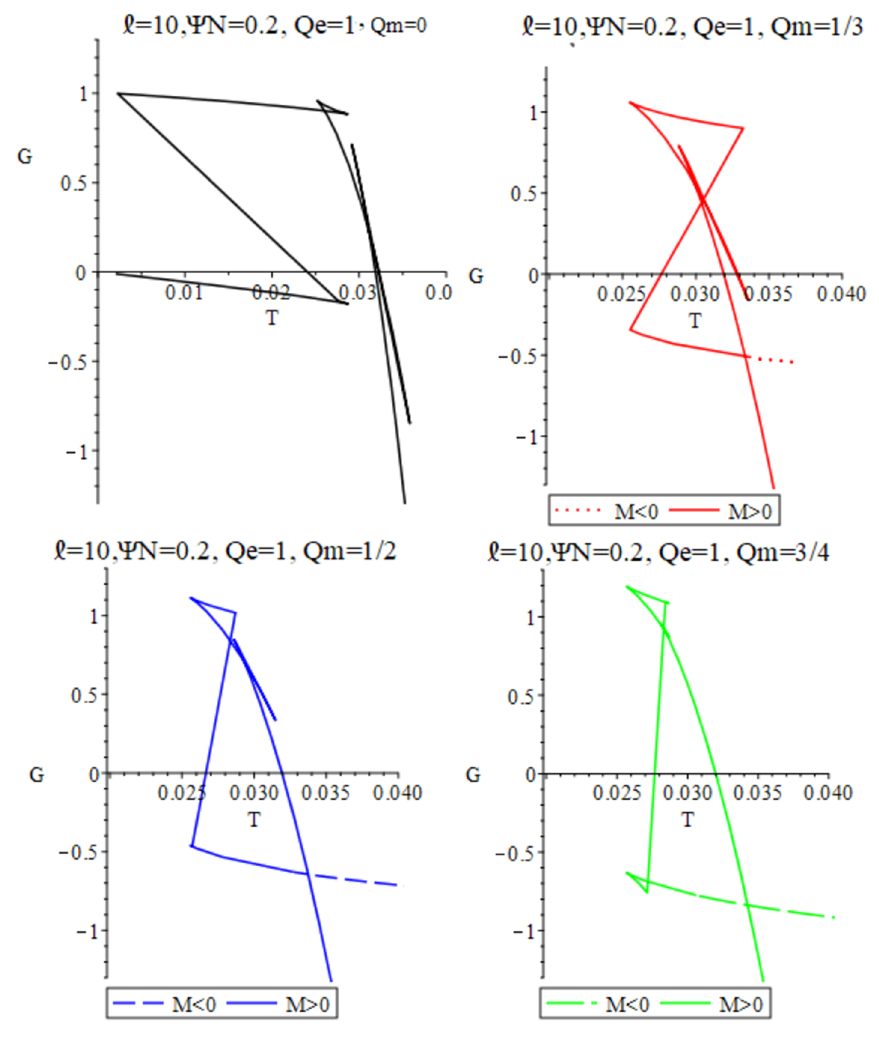
Figure 17 . Formation of Inverted Swallowtails. This sequence of diagrams shows how the inverted swallowtails form as the magnetic charge increases. Note the appearance of an additional narrow swallowtail on the unstable large black hole branch at the right for smaller values of Q m